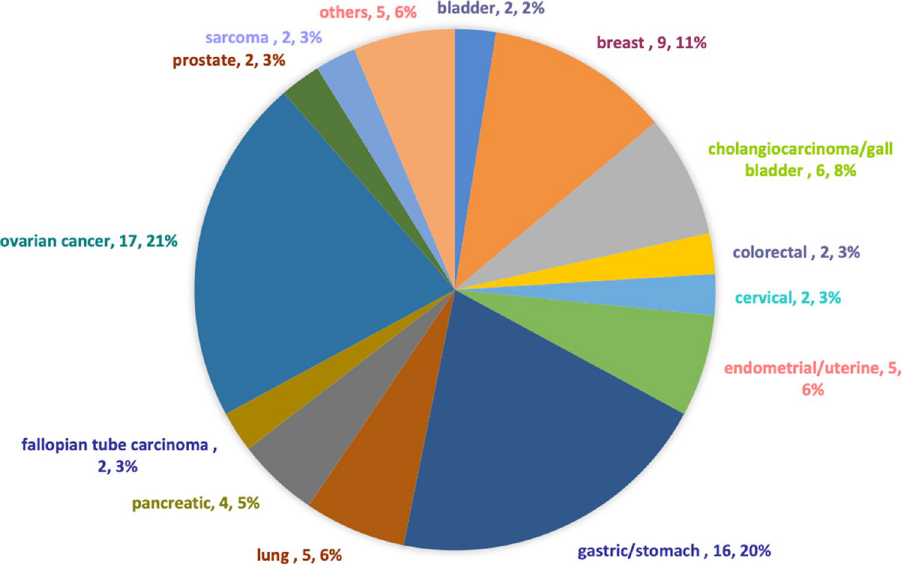
Figure 1. A pie chart demonstrates frequency of CCNE1 amplification per tumor type in patients who were seen at a designated phase I cancer trial service (n = 79).